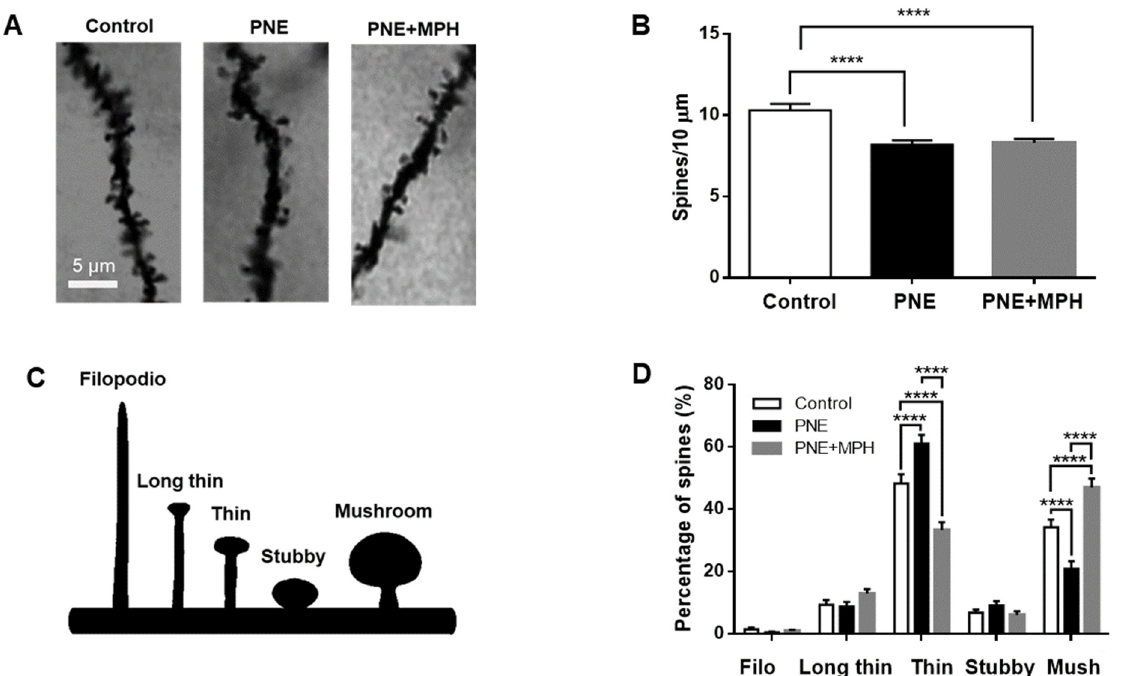
Figure 5. Density of dendritic spines in hippocampal neurons is reduced in PNE animals with a significant increase in fraction of immature thin-type spines and reduction of mature mushroom-type spines. MPH administration restores maturation of spines, but not density. ( A ) Microphotographs of spines on dendrites of Golgi-stained pyramidal neurons of the CA1 area of hippocampal sections from no − PNE (control), PNE, and MPH-treated PNE mice (PNE + MPH). ( B ) Bar plot: Dendritic spine density (per 10 µ m) in CA1 pyramidal neurons of no − PNE, PNE, and MPH-treated hippocampal slices. PNE animals exhibit significantly lower spine density compared to control (no − PNE) mice (PNE: 8.18 ± 0.272, n = 824 vs. control: 10.03 ± 0.389, n = 581 **** p ≤ 0.0001). Spine densities in PNE and MPH-treated PNE mice are not significantly different (PNE: 8.18 ± 0.272, n = 824 vs. MPH-treated PNE: 8.29 ± 0.232, n = 622, p > 0.05, one-way ANOVA with post hoc Tukey Test). ( C ) Schematic representation of morphological classification of dendritic spines. Left-right sequence represents maturation states of spines during brain development. ( D ) Bar plot: Quantification of different types of dendritic spines (filopodia, long/thin, thin, stubby, and mushroom) in pyramidal neurons contained in hippocampal slices from control, PNE, and MPH-treated PNE mice. The percentage of thin-type spines is significantly higher in PNE neurons compared to control neurons (PNE: 61.0 ± 2.822% vs. control: 48.23 ± 2.947%, **** p ≤ 0.0001). By contrast, the fraction of mushroom-type spines is significantly lower in PNE neurons compared to control neurons (PNE: 20.8 ± 2.517% vs. control: 34.25 ± 2.411%, **** p < 0.0001). CA1 hippocampal neurons of MPH-treated